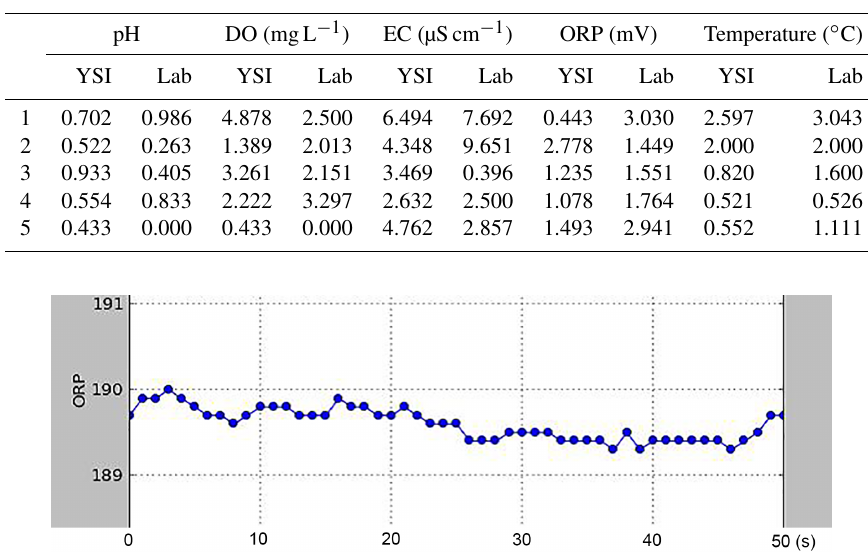
Figure 5. Real-time data collection from Python framework module for